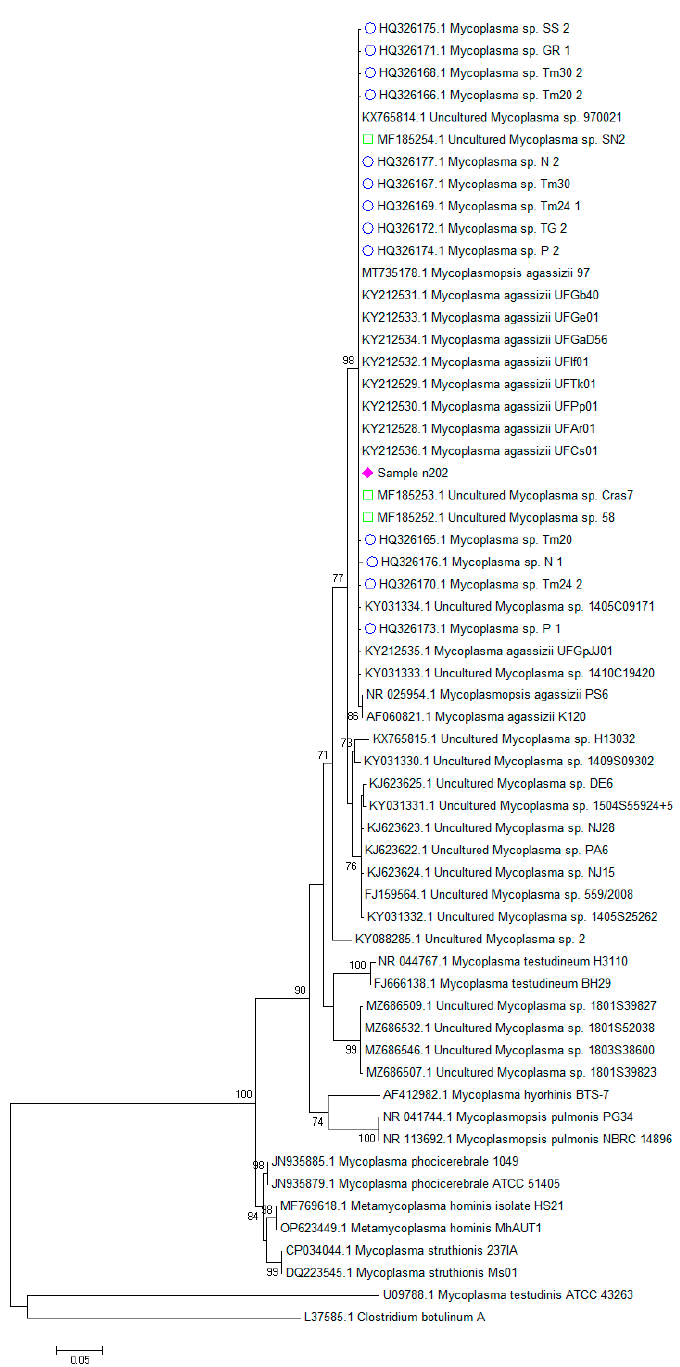
Figure 1. Phylogenetic analysis of the 16S rRNA partial sequence of the samples and of other mycoplasmas. Clostridium botulinum strain ATCC 25,763 was also included in the dataset as an outgroup. The evolutionary history was inferred using the maximum likelihood method based on the Kimura-2-parameter model with a gamma distribution with invariant sites and with bootstrap values based on 1000 repetitions. The tree is unrooted. Bootstrap support values above 70% are represented. As the sequences obtained in this study were identical, only a representative sequence was included in the tree and labeled with a diamond ( (cid:7) ). Sequences obtained previously in tortoises in Italy are labeled with a circle ( ) [7] and a square ( (cid:3) ) (cid:35)